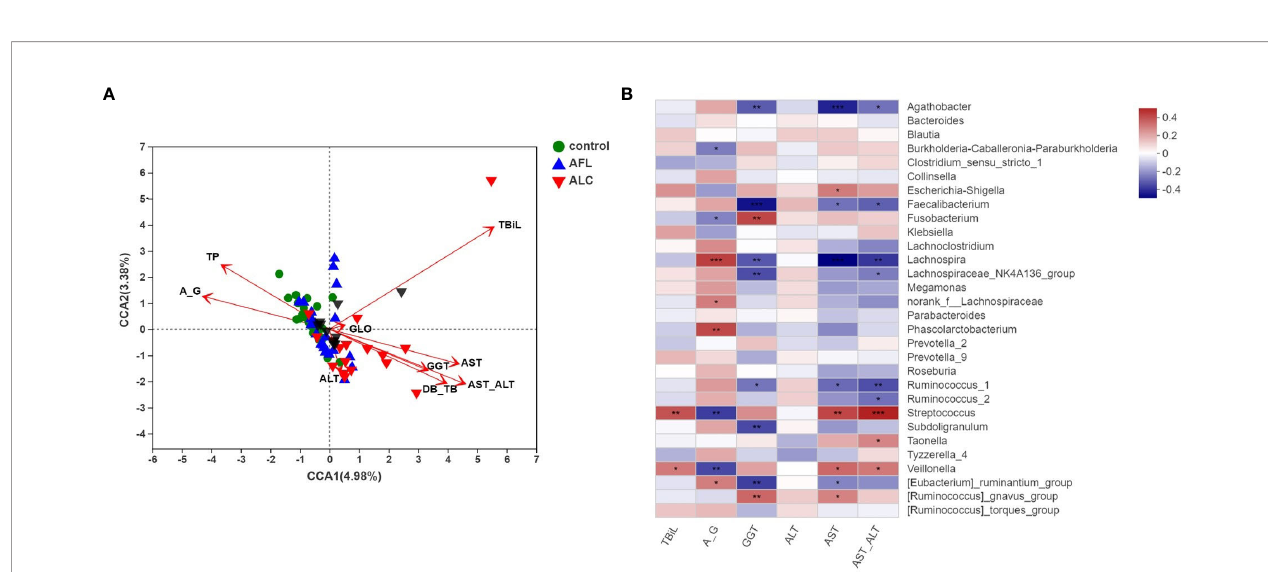
FIGURE 4 | Correlation analysis of the structures of gut microbiota and clinical factors. (A) CCA analysis on genus level showed the correlations between the bacterial community structures and the indicators of clinical laboratory tests. (B) Heatmap analysis of the correlation between the top 30 predominant bacteria at genus level and the clinical factors. Red spots represent a positive correlation, while blue spots represent a negative correlation. *P < 0.05, **P < 0.01, ***P < 0.001.